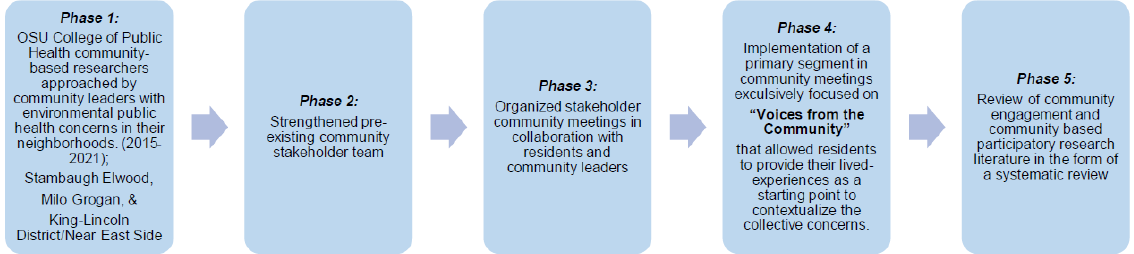
Figure 2. The phases of progression and development of the E 6 framework towards acquisition of